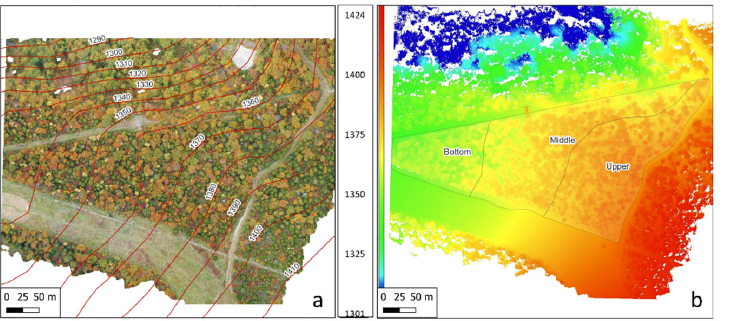
Figure 4. ( a ) Ten-meter contour line on the RGB orthomosaic of the study site, and ( b ) the study site divided into three areas related to their altitude: bottom (1330 m–1350 m), middle (1350 m– 1370 m), and upper (1370 m–1390 m).